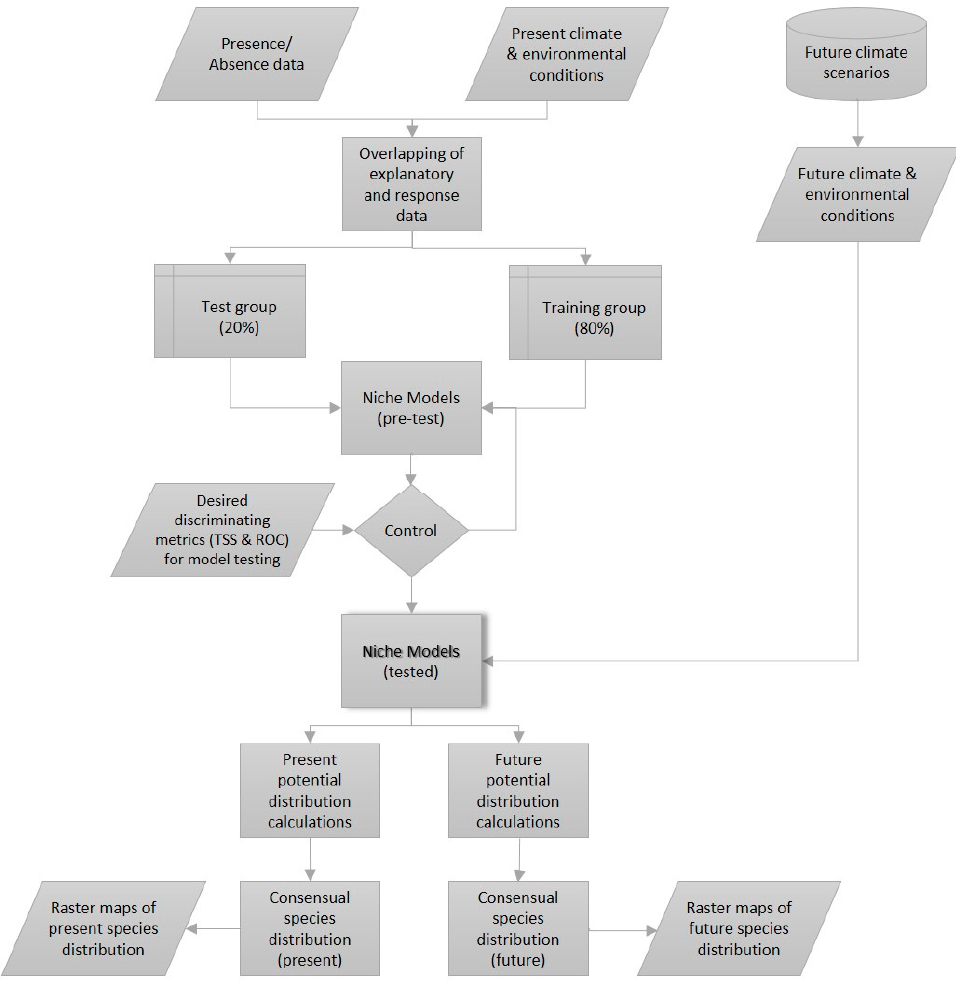
Figure 2. Simplified representation of the bioclimatic modelling technique used in this study (Adapted from Berteaux et al., 2010 [41]).